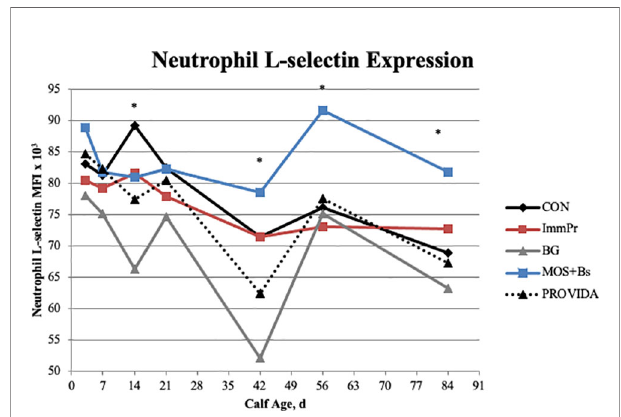
FIGURE 8 | The surface expression of L-selectin on neutrophils was measured on d 3, 7, 14, 21, 42, 56, and 84. There was no treatment x time interaction, but there was a difference in the sliced effects. The MOS+Bs treatment had increased L-selectin when compared to other treatments; MOS+Bs vs. CON ( P ≤ 0.032) on d 56 and 84; MOS+Bs vs. ImmPr ( P = 0.027) on d 56; MOS+Bs vs. BG ( P ≤ 0.021) on d 14, 42, 56, and 84; MOS+Bs vs. PROVIDA ( P ≤ 0.027) on d 42, 56, and 84. The BG treatment had decreased L-selectin expression when compared to other treatments; BG vs. CON ( P ≤ 0.001) on d 14 and 42; BG vs. ImmPr ( P ≤ 0.009) on d 14 and 42; BG vs. MOS+Bs ( P ≤ 0.021) on d 14, 42, 56, and 84; BG vs. PROVIDA ( P ≤ 0.078) on d 14 and 42. Largest SEM per time point are expressed as MFI x 10 3 and include 6.120, 6.235, 6.377, 6.360, 6.377, 6.385, and 6.409 for d 3, 7, 14, 21, 42, 56, and 84, respectively. An * indicates a treatment difference of ( P ≤ 0.05) when treatments were sliced by